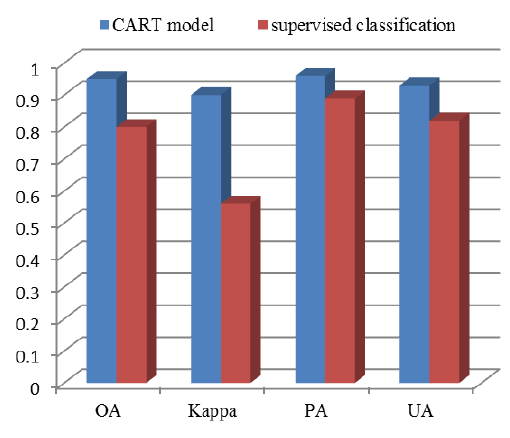
Figure 5 Results of precision